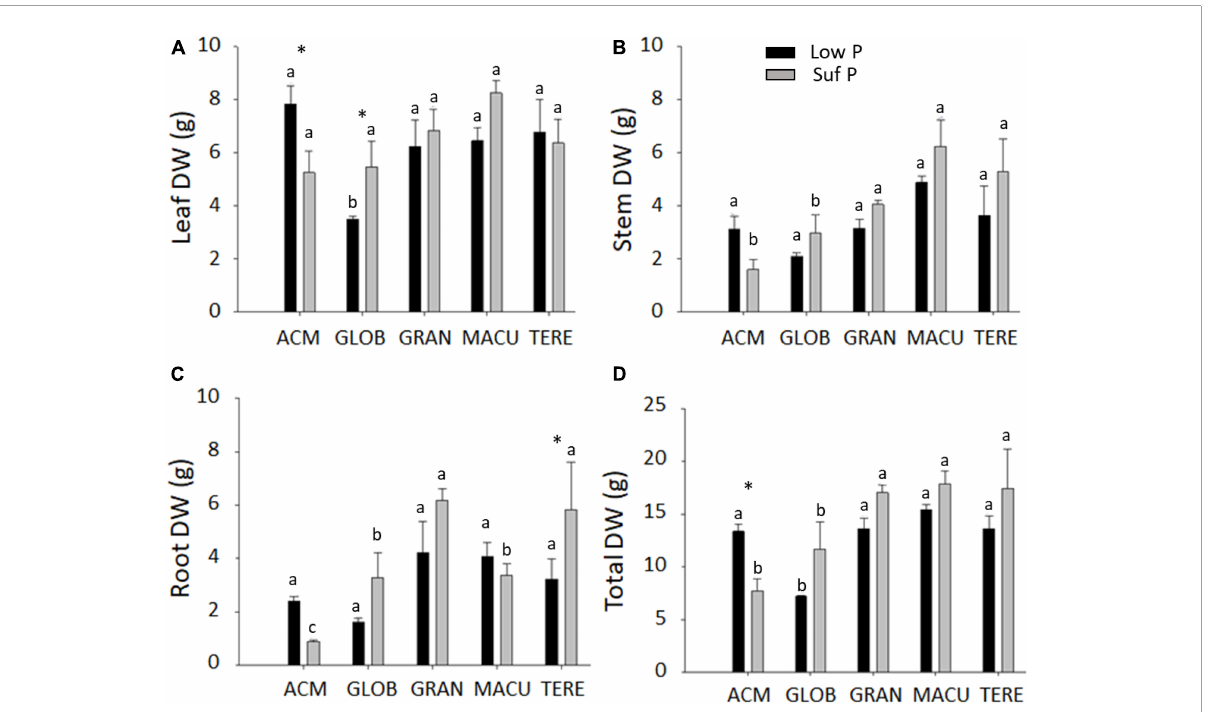
TABLE 1 Concentrations of phosphorus in the roots, stems and leaves of five eucalypt species cultivated in soil with low (Low P) and sufficient (Suf P) phosphorus availability. Species Phosphorus Roots Stems